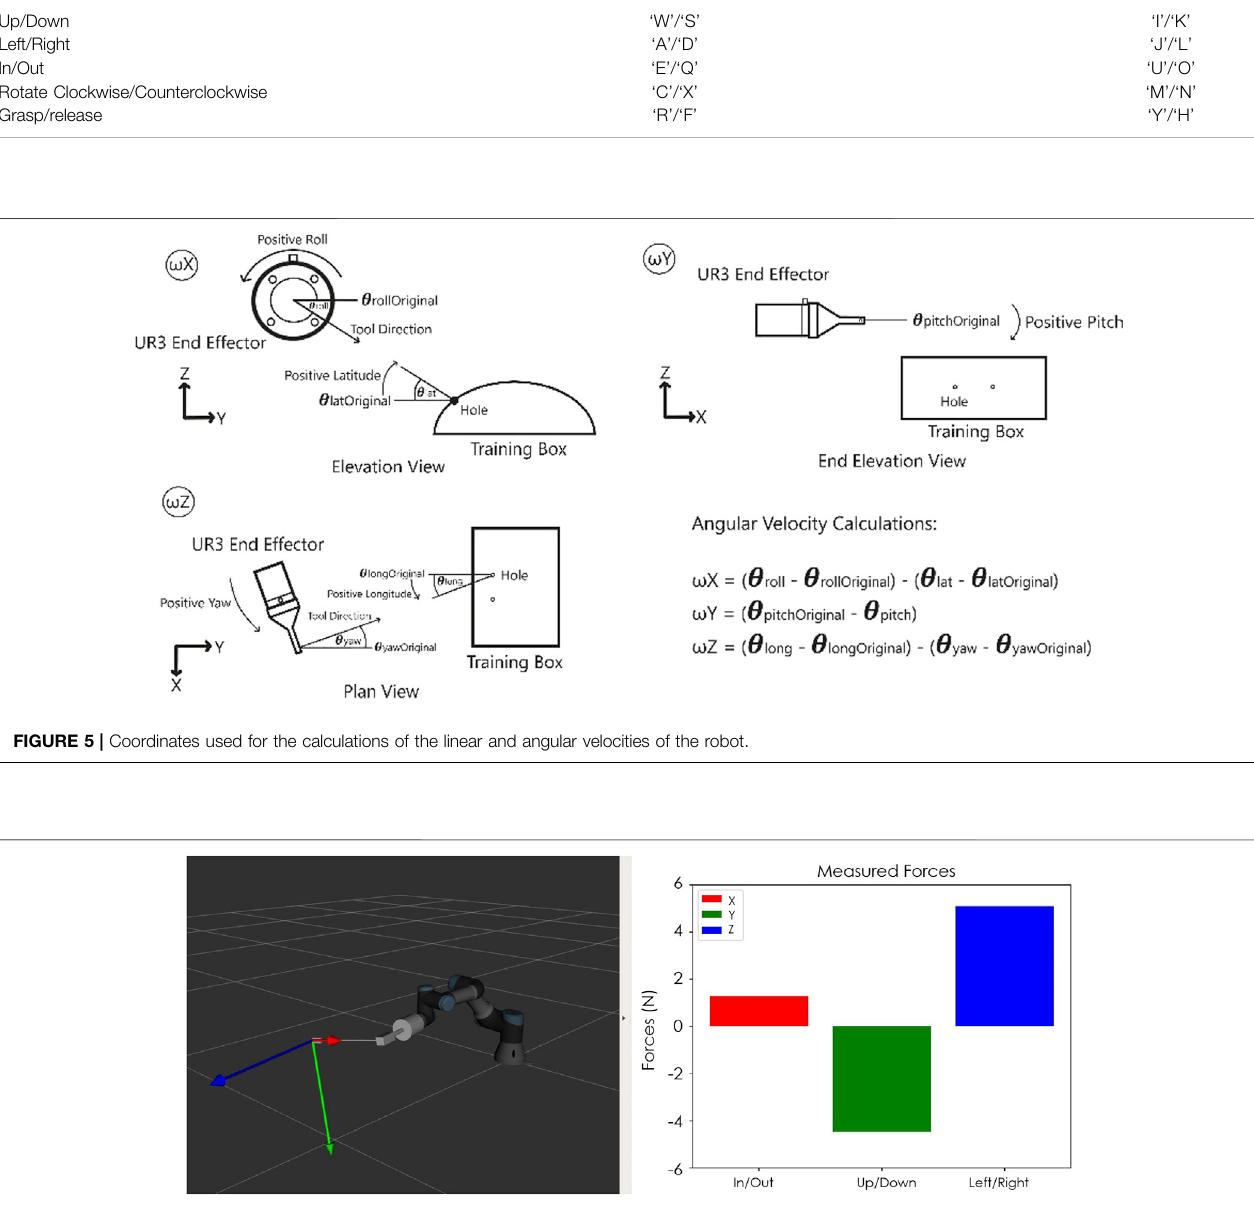
FIGURE 6 | Visual feedback of forces that can be provided during the teleoperation of the robot by keyboard.